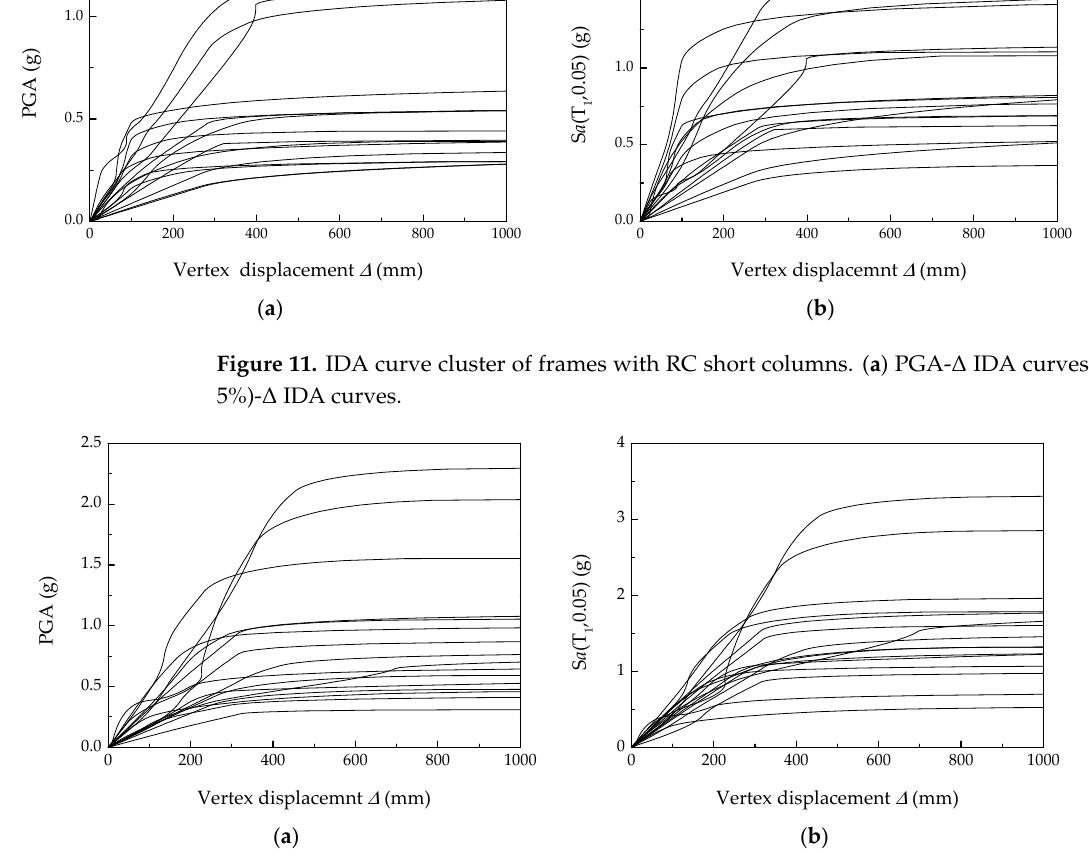
Figure 12. IDA curve cluster of frames with ECC short columns. (a)PGA- Δ IDA curves; (b) S a ( T 1, 5%)- Δ IDA curves.